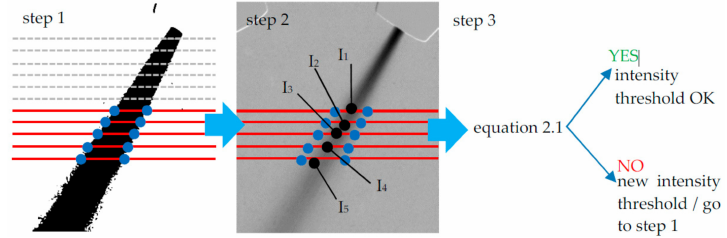
Figure 6. Scheme of the iterative method employed to determine the intensity